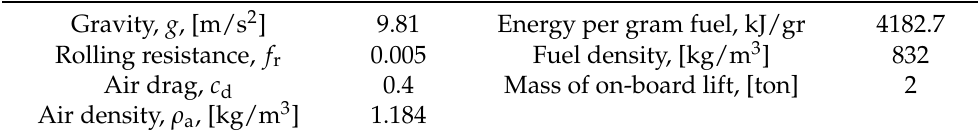
Table A2. Physical parameters.